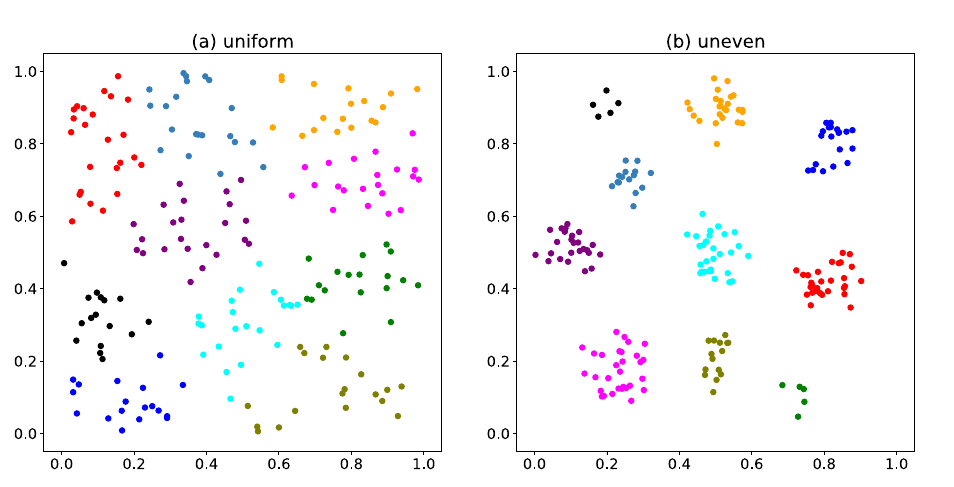
Figure 4. Clustering results obtained using SB for the ( a ) uniformly and ( b ) unevenly distributed